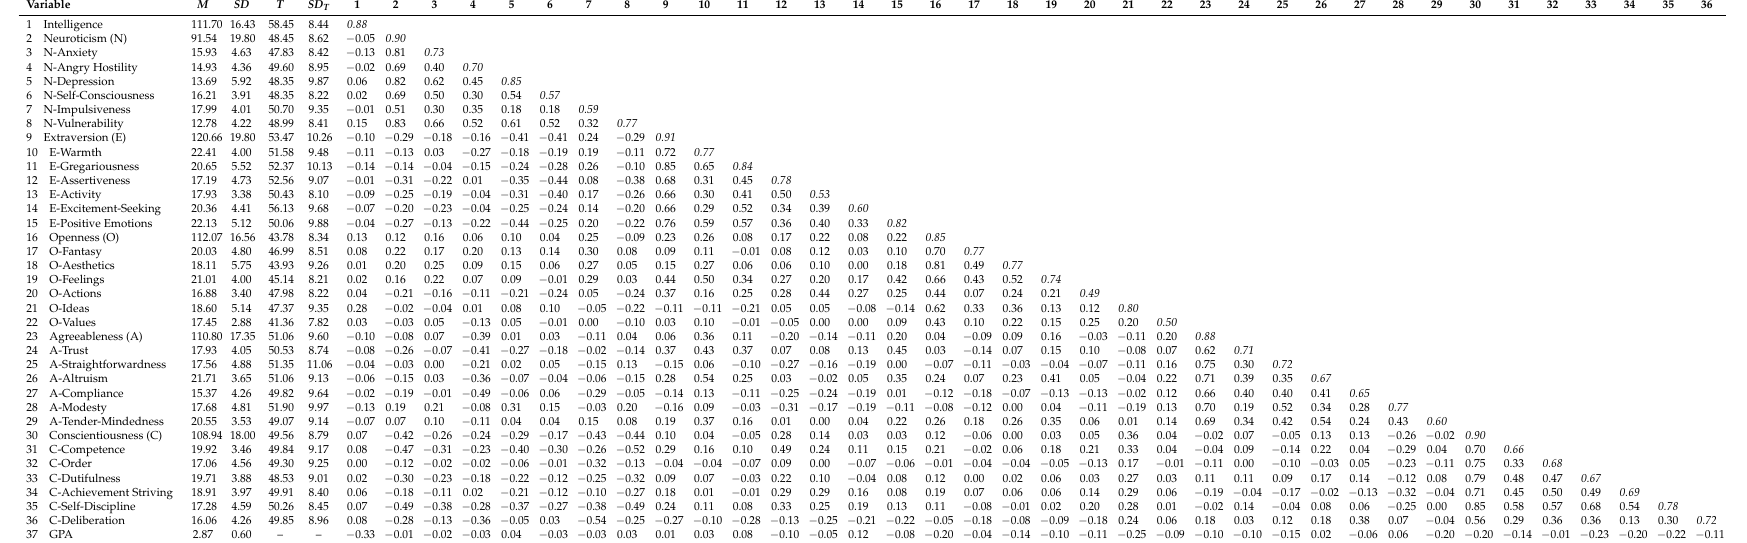
Table 3. The means ( M ), standard deviations ( SD ), reliabilities, and intercorrelations for intelligence, the Big Five personality dimensions, their facets, and grade point average